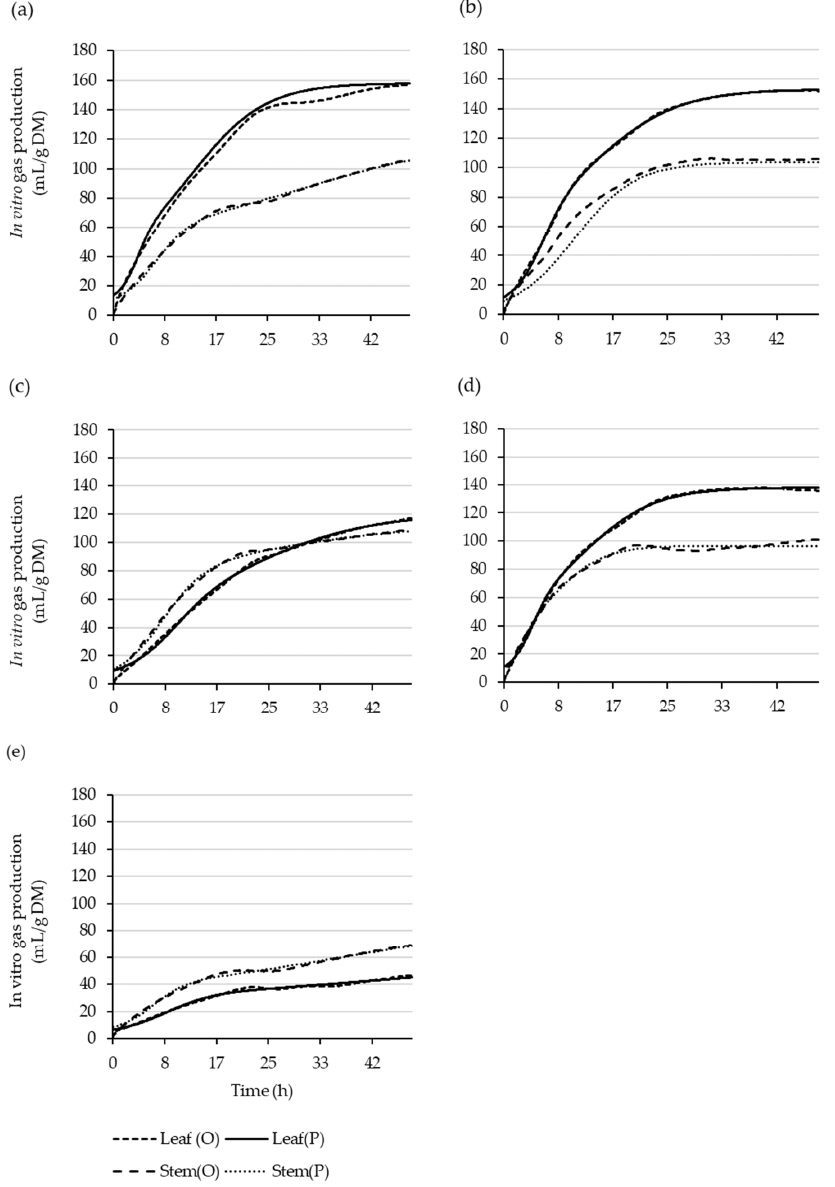
Figure 2. Observed (O) and the dual ‐ pool ‐ model ‐ predicted (P) leaf and stem cumulative gas ‐ production curves over 48 h for Coprosma robusta ( a ), Griselinia littoralis ( b ), Hoheria populnea ( c ), Pittosporum crassifolium ( d ), and Salix schwerinii ( e ).